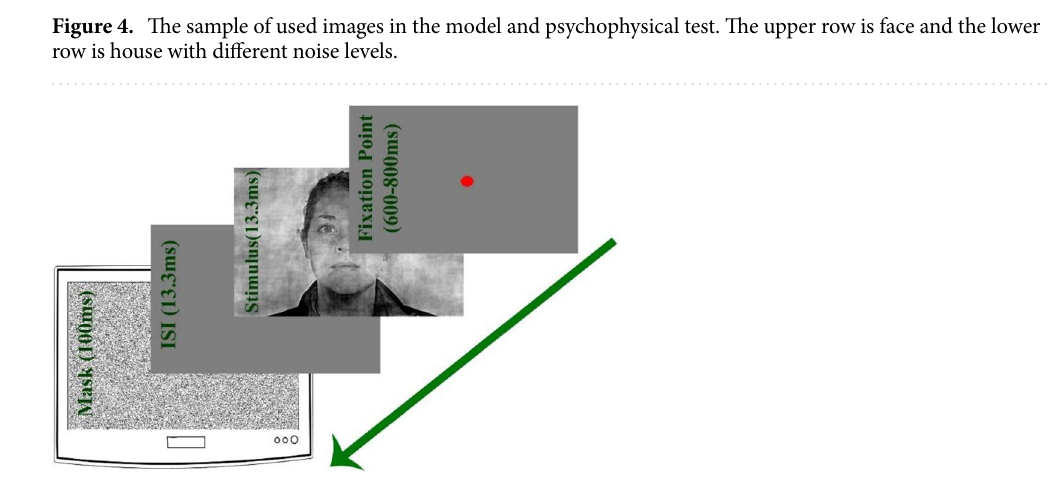
Figure 5. Psychophysics paradigm. Each trial starts by 600–800 ms presentation of a red dot in the center. The stimulus and a blank gray page will be both presented for 13.3 ms sequentially. The trial will be finished by presentation of a noisy mask for 100